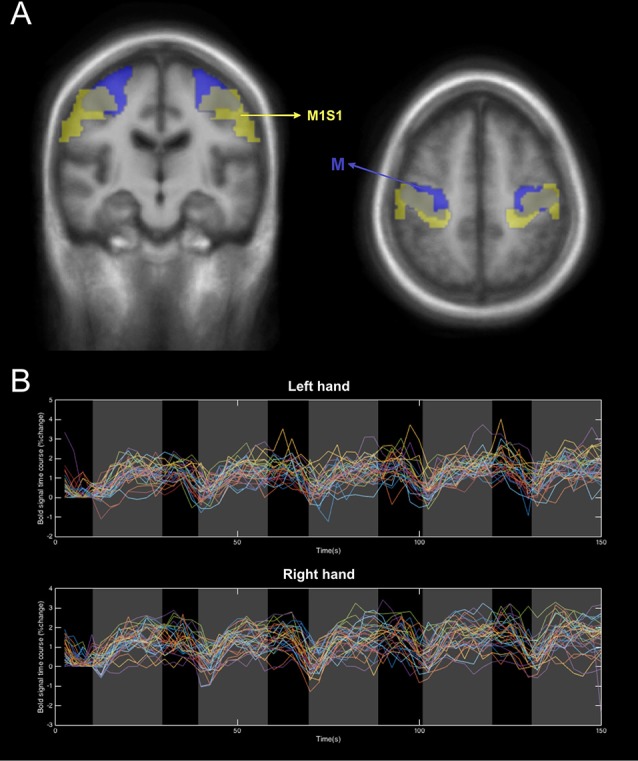
An illustration of the two types of ROIs used in this study. (A) The Atlas-based ROIs, M (yellow) and the activation ROIs, M1S1 (Blue). (B) An example of the BOLD signal extracted from the M ROI of the control group during activation of left and right hands.